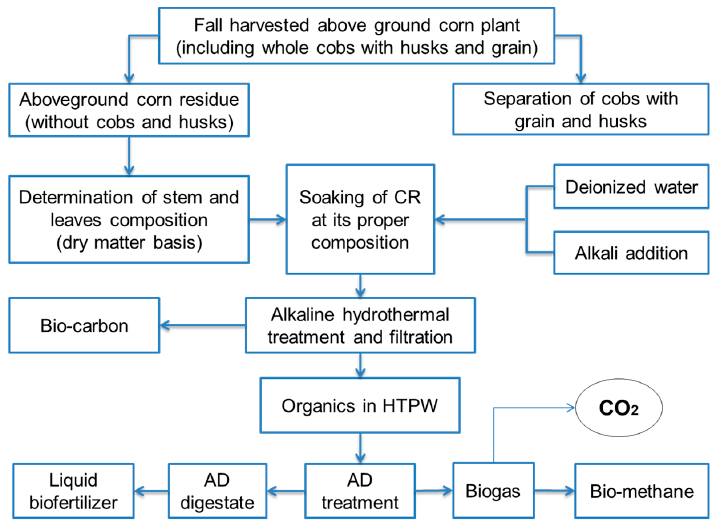
Figure 2. Flow diagram of alkaline hydrothermal pretreatment process, its products separation and resources recovery.